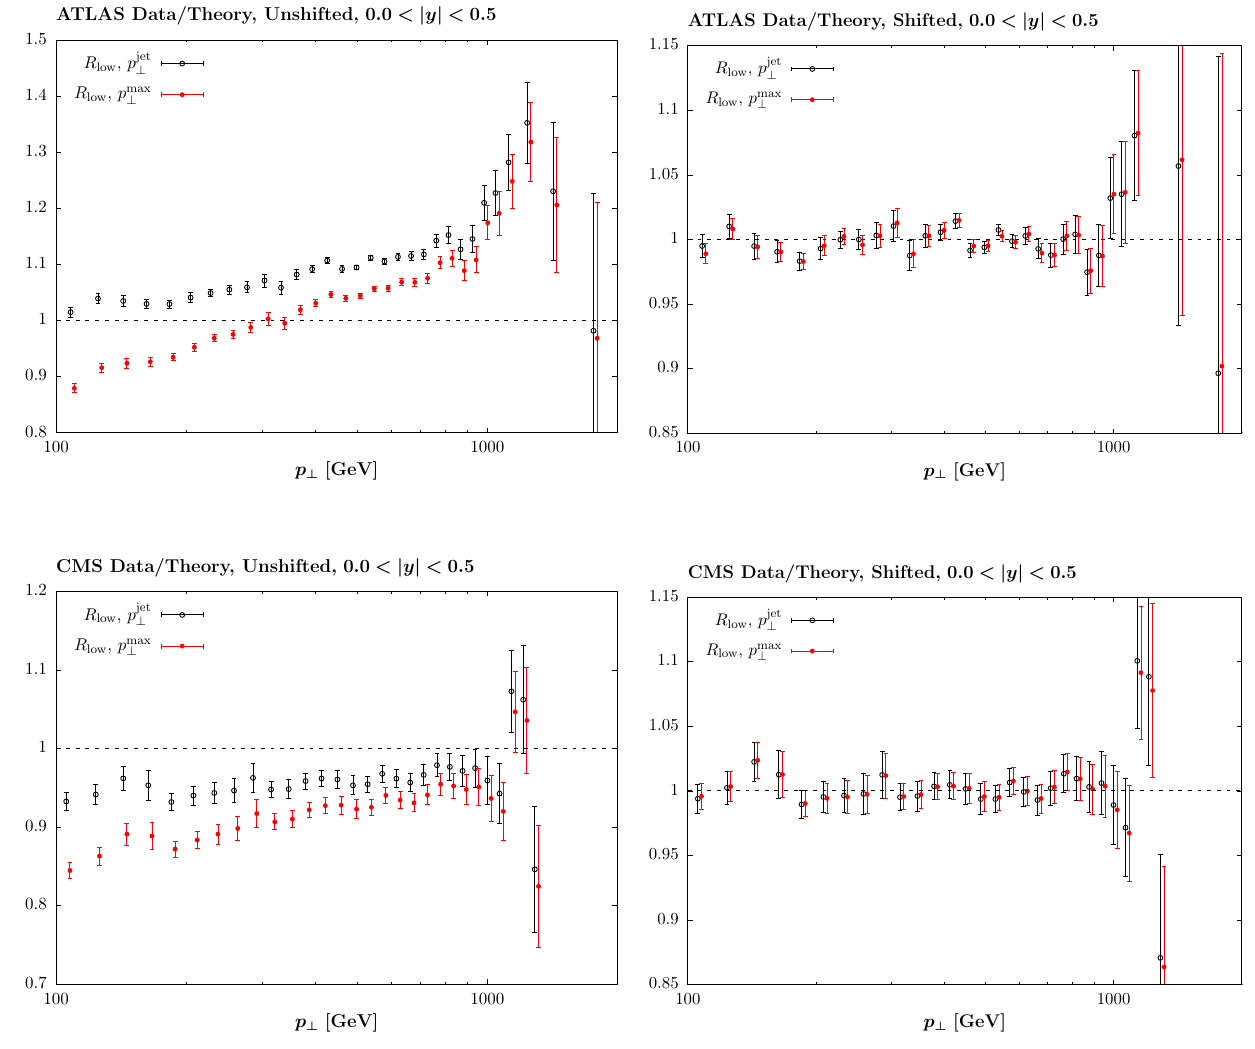
Fig. 8 Data/theory for the NNLO fit including the combined ATLAS and CMS data with the lower R radius choice and for both choices of scale. The comparison in the central rapidity bin for the ATLAS (CMS) data is shown in the upper (lower) plots. The result before and after the